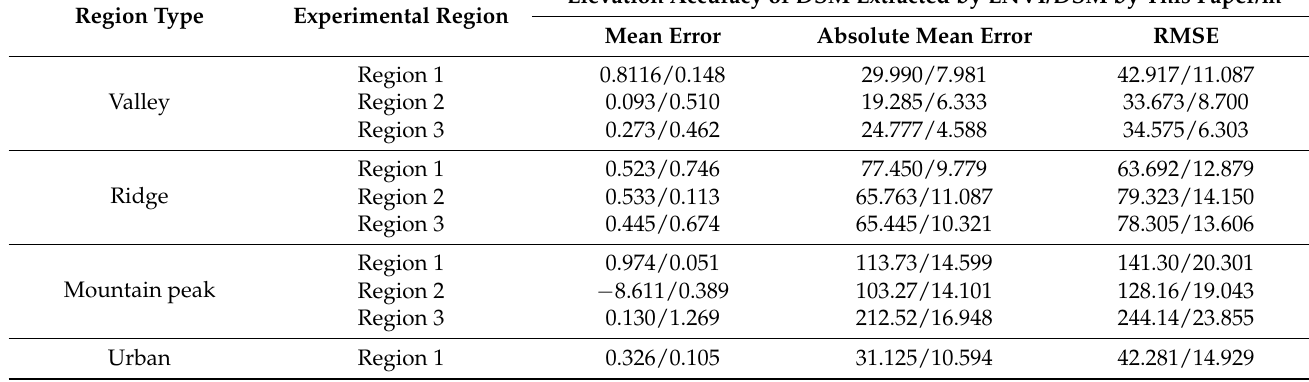
Table 4. Overall accuracy evaluation results of DSM extracted from different regions.